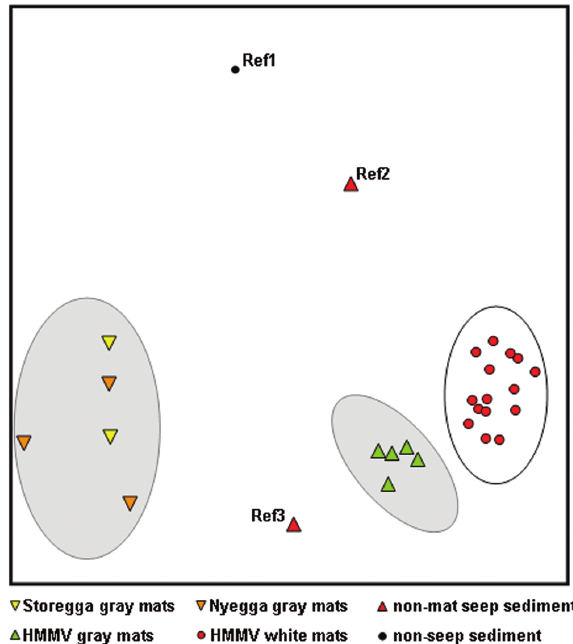
Fig. 4. NMDS plot (based on a Bray-Curtis distance matrix) of ARISA-derived bacterial community profiles of the Storegga, Nyegga and H˚akon Mosby mud volcano (HMMV) gray mats as well as HMMV white mats. The stress value of the ordination was 0.095, indicating a good representation of the original matrix into the reduced space. Non-seep associated sediment (Ref1) was ob- tained in the vicinity of the Storegga/Nyegga area with a multiple corer (2006). Non-mat covered seep references were obtained with push cores at the HMMV: Ref2 was recovered from the periphery (tube worm field) of the mud volcano (2009), while Ref3 was taken approx. 10m away from a white mat (2007).